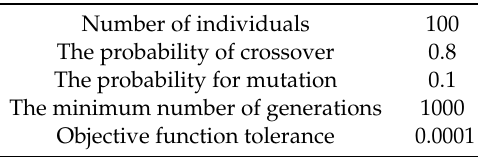
Table 3. Control parameters in GA and NSGA-II.